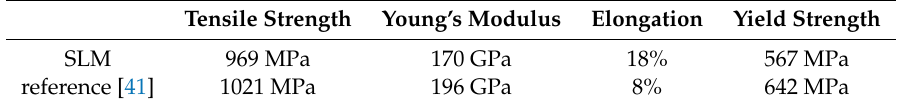
Table 3. Tensile strength, Young’s modulus, elongation and yield strength of SLM fabricated CoCrW specimens.